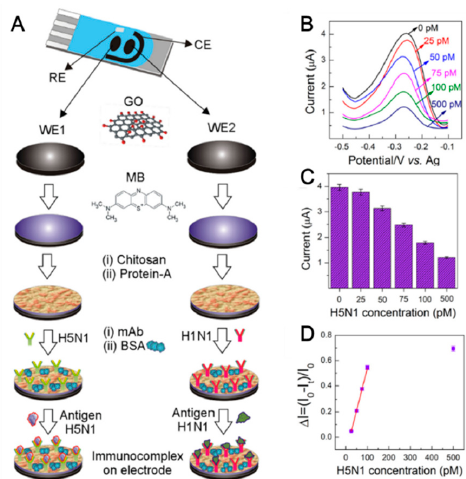
Figure 2. ( A ) Representation of dual screen-printed electrode (SPE) and fabrication process of immunosensor platform. WE–working electrode, CE–counter electrode, and RE–reference electrode. ( B ) Representative differential pulse voltammetry (DPVs) of graphene oxide-methylene blue/circumsporozoite (GO-MB/CS)/protein-A/anti-H1N1 electrodes against various concentrations of antigen H1N1. ( C ) The selected relevant peak voltammetric histogram. ( D ) Calibration curve derived from the DPVs expressed in Δ I. Δ I = (I0 ‒ It/I0), where I0 is the absolute peak current value of the modified electrode in phosphate-buffered saline phosphate-buffered saline (PBS) without antigen application, and it is the peak current value of the modified electrode measured in PBS with the desired concentration of the antigen (n = 3). (Reproduced with permission from [32], published by Elsevier,